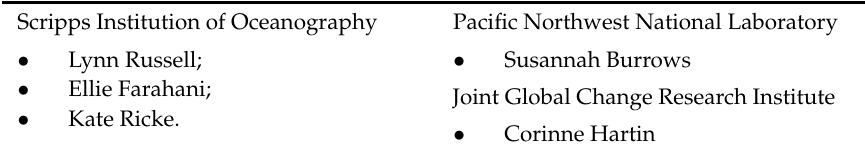
Table 2. Final reviewers during beta launch, with their associated